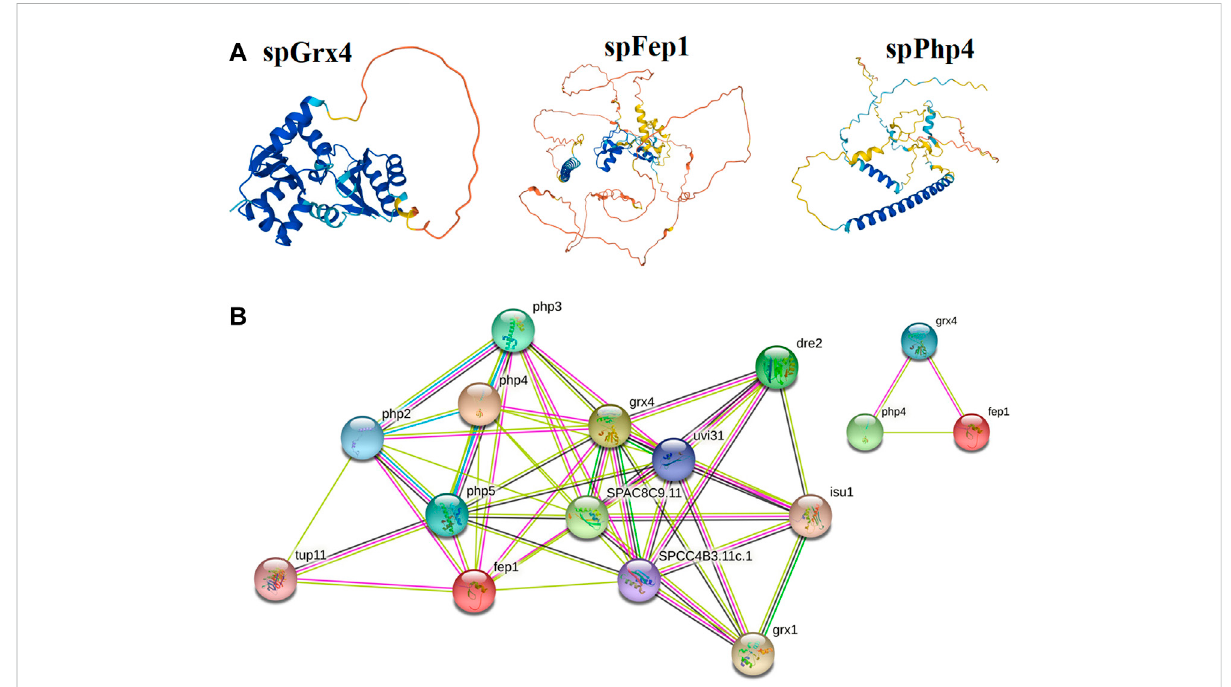
FIGURE 7 Protein analysis; (A) Thepredictedthree-dimensional structuresofspGrx4, spFep1, and spPhp4. (B) The Protein-proteininteractionnetwork building amongspGrx4,spFep1,andspPhp4wasperformedusingthePhyre2serverinanintensivemode.Rainbowcolorsvisualizedproteinmodelswerevisualized byrainbowcolorsinthedirectionfromNtoCterminus.Unknown3Dstructuresarerepresentedbyemptynodes,knownorpredicted3Dstructuresby fi lled nodes, query proteins, and the fi rst shell of interactors by colored nodes, and the second shell of interactors by white nodes.